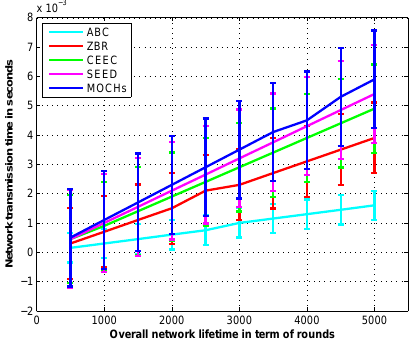
Figure 15. The transmission time in the life cycle of the network with different density of the nodes in the sensing